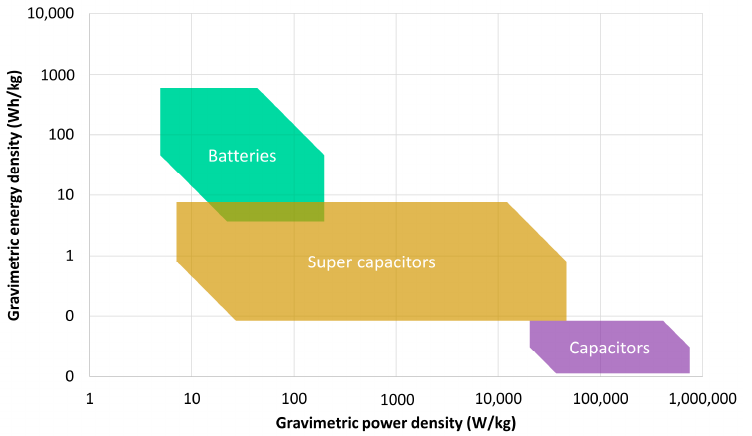
Figure 6. Ragone plot with gravimetric energy density and power density of different categories of ESS for marine applications. Elaborated from [123,126].